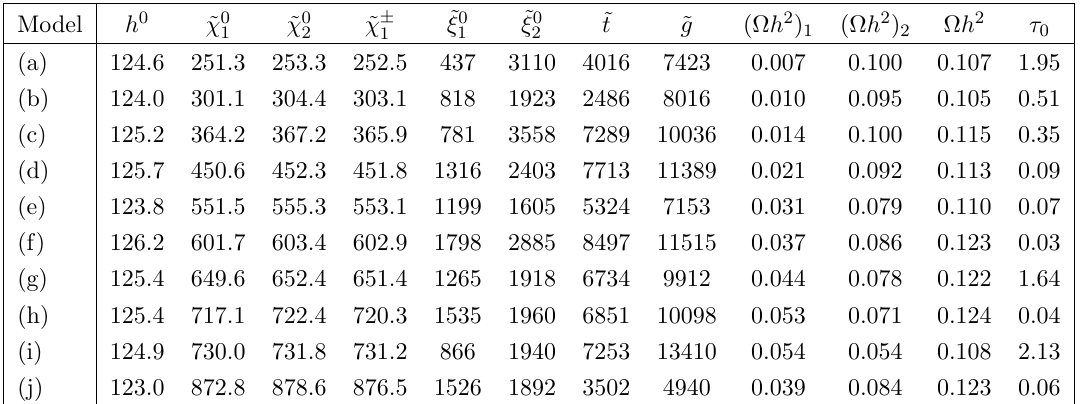
Table 2. Display of the Higgs boson ( h 0 ) mass, the stop (~ t ) mass, the gluino (~ g ) mass, the relevant electroweakino (~ (cid:31) 0 ; ~ (cid:31) 0 ; ~ (cid:31) (cid:6) ) masses, the hidden sector neutralino (cid:24) 0 1 2 1 for the benchmarks of table 1 computed at the electroweak scale. (cid:28) 0 (in s) is the lifetime of the hidden sector neutralino ~ (cid:24) 0 which has a decay consistent with the BBN constraint. All masses are 1 in